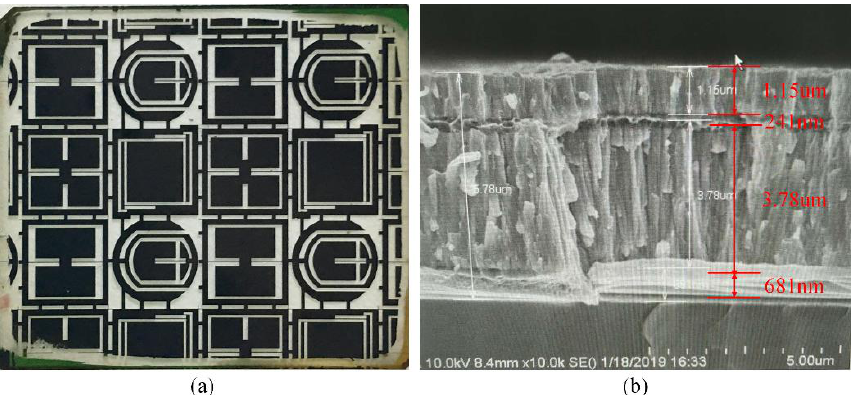
Figure 13. ( a ) The picture of the manufactured mask layer; ( b ) the SEM image of the “sandwich”